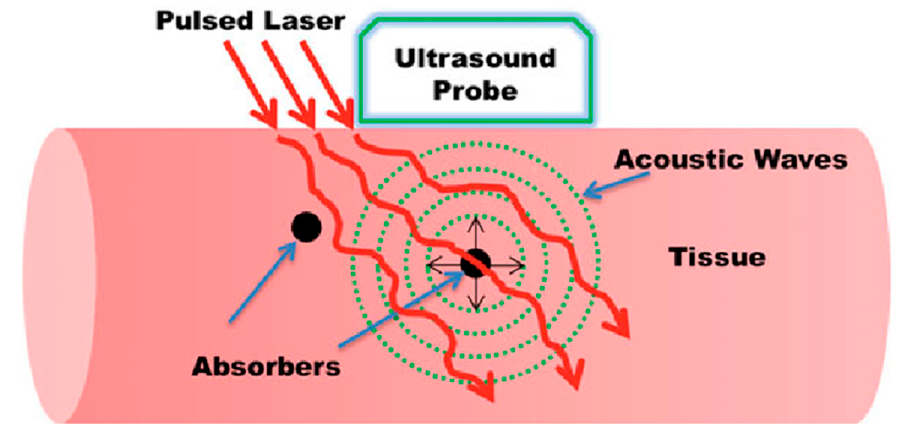
Figure 2. Basic principle of biomedical photoacoustic imaging. Reproduced with permission from Handheld Probe-Based Dual Mode Ultrasound/Photoacoustics for Biomedical Imaging. In: Olivo M., Dinish U. (eds) Frontiers in Biophotonics for Translational Medicine. Progress in Optical Science and Photonics, vol 3. Springer, Singapore (2016). Copyright 2016 Springer,